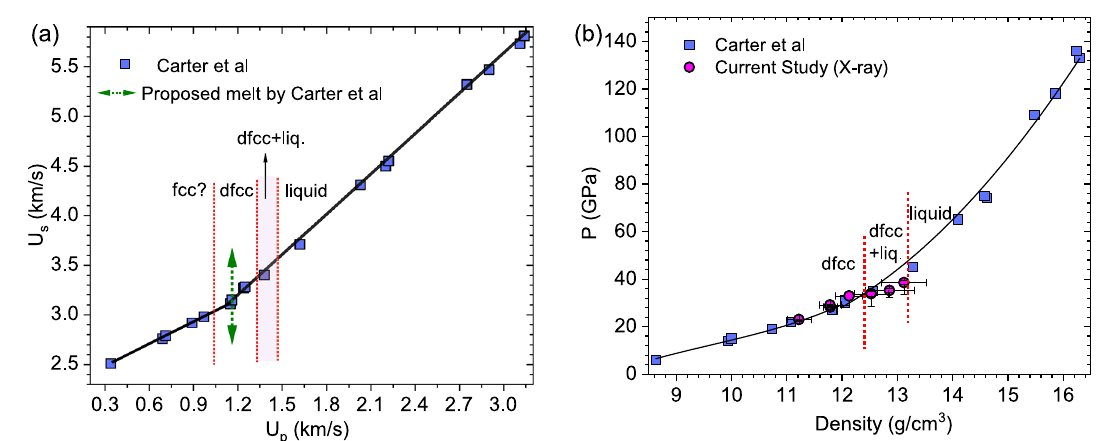
u p and ( b ) pressure-density plane. Square symbols are the data from Carter Figure 8. ( a ) Hugoniot in the U s − et al. 15 , magenta-filled circles are the densities calculated using x-ray diffraction data. Black solid lines are guide to the eye. The green-dashed arrowed line corresponds to where Carter et al. 15 proposed melting would occur. The red boundaries line are drawn based on the phase boundaries observed in x-ray data from this